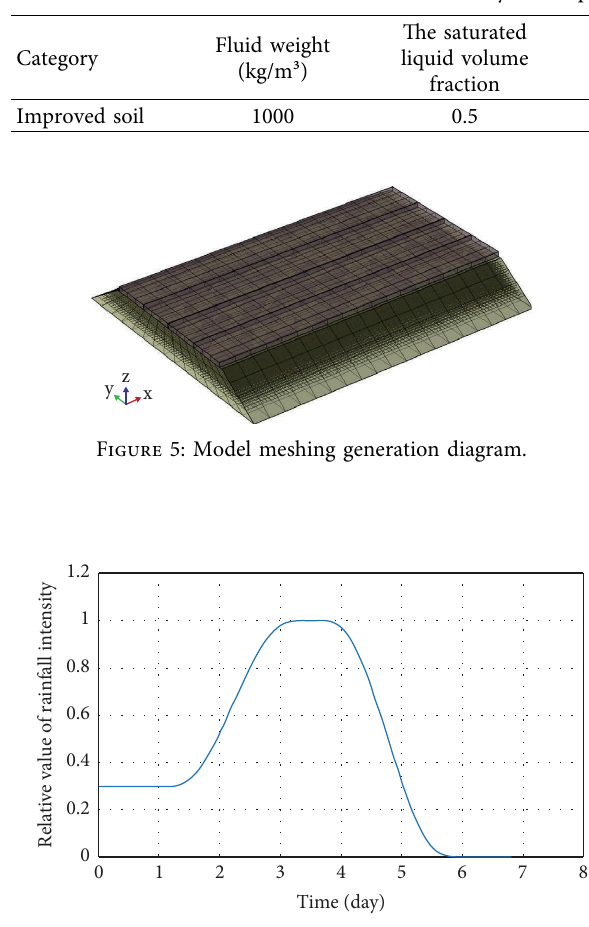
Table 4: Hydraulic parameters of embankment soil.